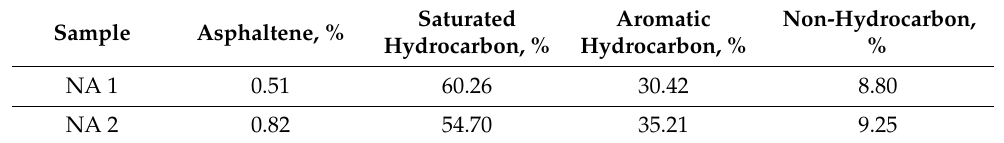
Table 4. Composition of pyrolysis oil in the Nongan in situ conversion project.